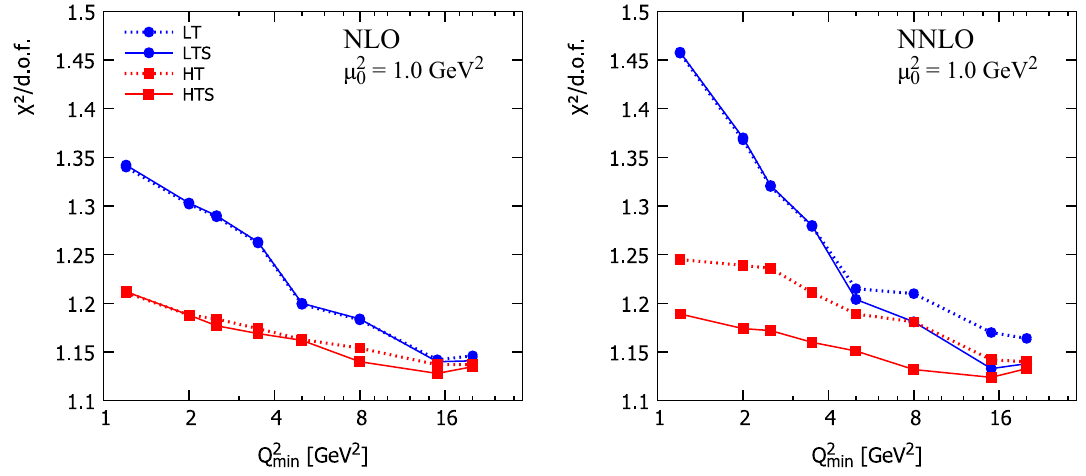
= 1 . 0GeV 2 fits to the data with the Q 2 ≥ Q 2 0